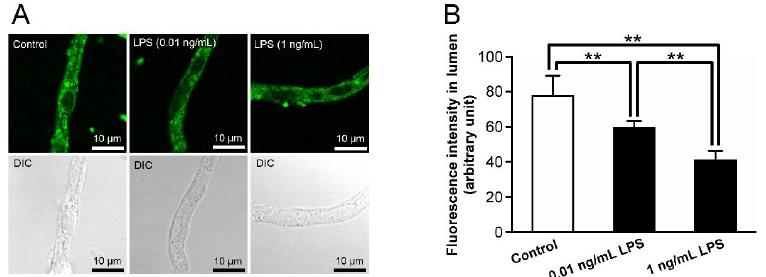
Figure 1. Alterations in P-gp activity in the retinal capillaries after LPS treatment. ( A ) Representative confocal images of isolated rat retinal capillaries after incubation with 4 µ M NBD-CSA for 60 min. The capillaries were preincubated with ECF buffer in the absence (control) or presence of LPS at a concentration 0.01 or 1 ng/mL for 30 min. ( B ) Quantification of NBD-CSA fluorescence in the lumens of retinal capillaries. Each column represents the mean value for 10 capillaries from a single preparation; variability is given by S.D. bars. Units are expressed as arbitrary fluorescence (scale 0–255). ** p < 0.01, significantly different between the groups. Capillary images were captured using a